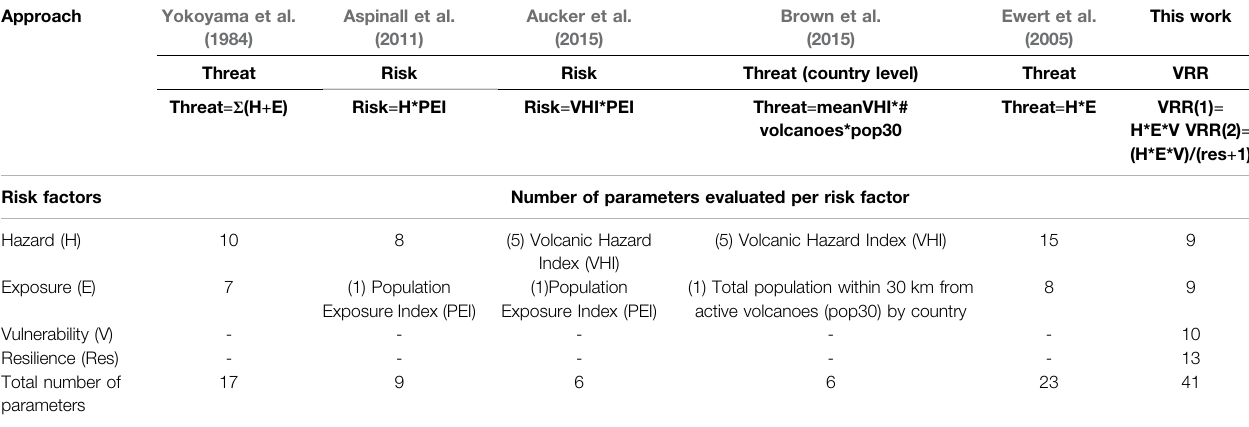
TABLE 6 | Comparison of the number of parameters and approach used in the new ranking strategy with previous volcanic ranking systems.